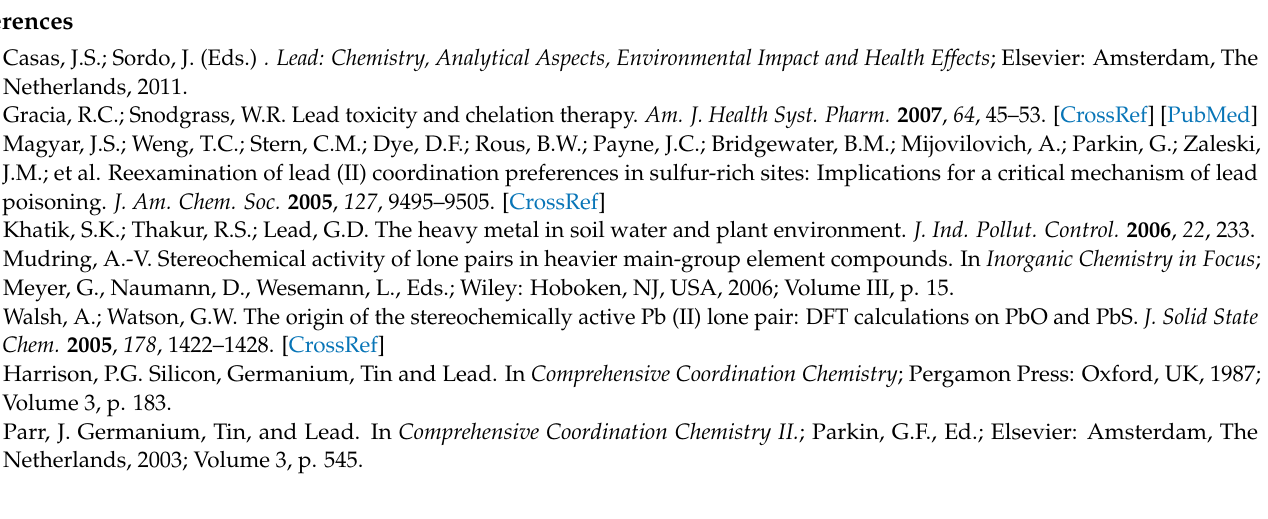
Supplementary Materials: The following are available online, Figure S1: Distance between the ELF Table S1: Pb-L distances in Angströms and L-Pb-L angles in degrees of the complexes optimized with the different